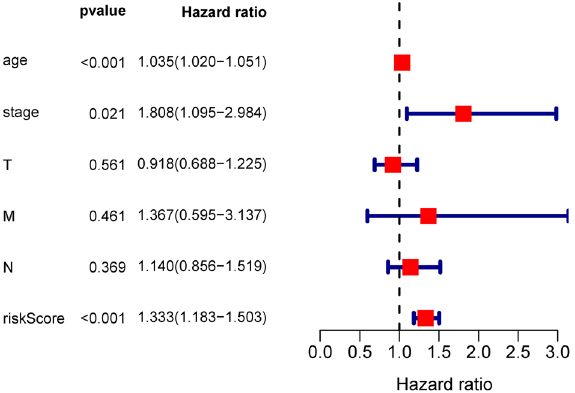
Figure 5. Forest plot of multivariate COX regression